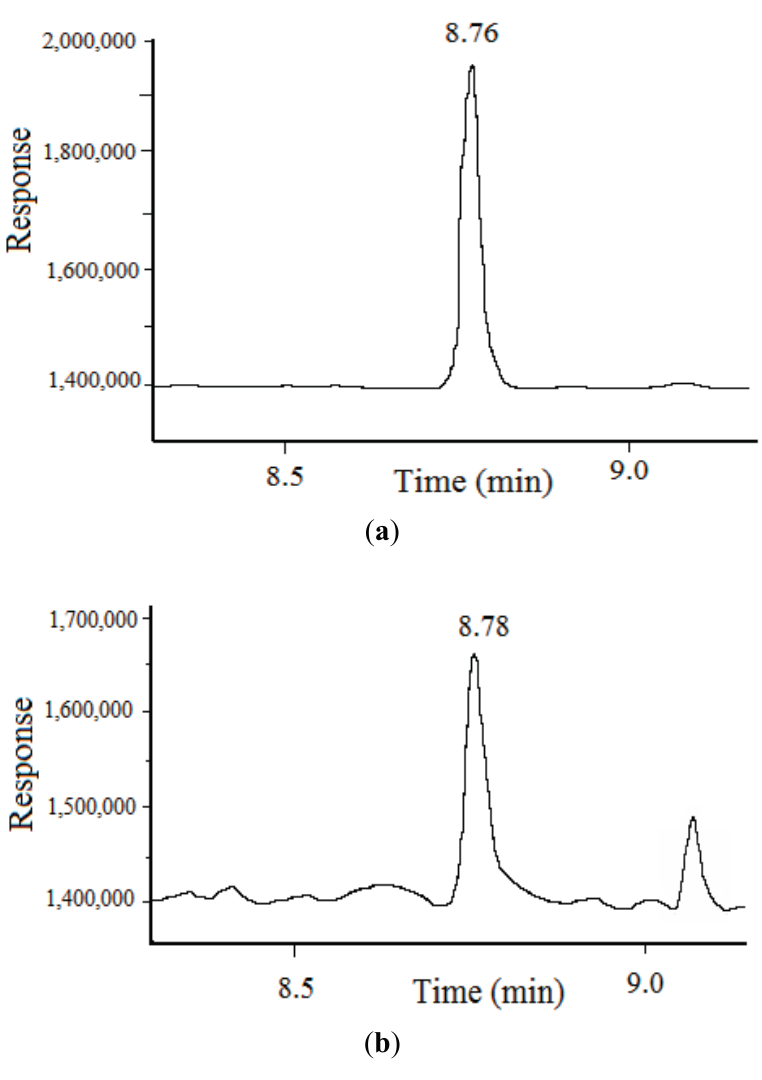
Figure 9. The chromatogram of CAP: ( a ) standard, 1 µg/kg; ( b ) carp muscles from the fish injected with CAP at a dose of 1 µg/kg.bw after 9 h from the time of